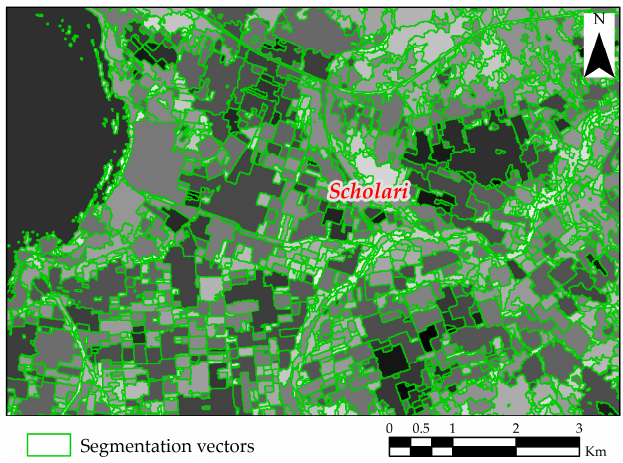
Figure 5. A representative scene from the segmented image with both summer and winter crops using R, G, B, Near Infrared (NIR) and Normalized Difference Vegetation Index (NDVI) channels.